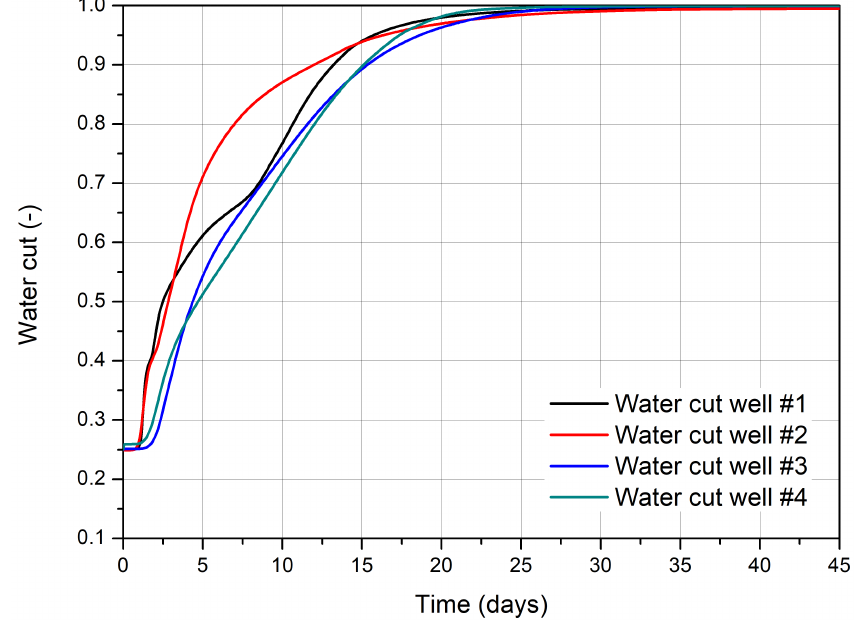
Figure 16. Water-cut for the different producer wells as a function of time. Well #1 corresponds to the northernmost well, and well #4 to the southernmost